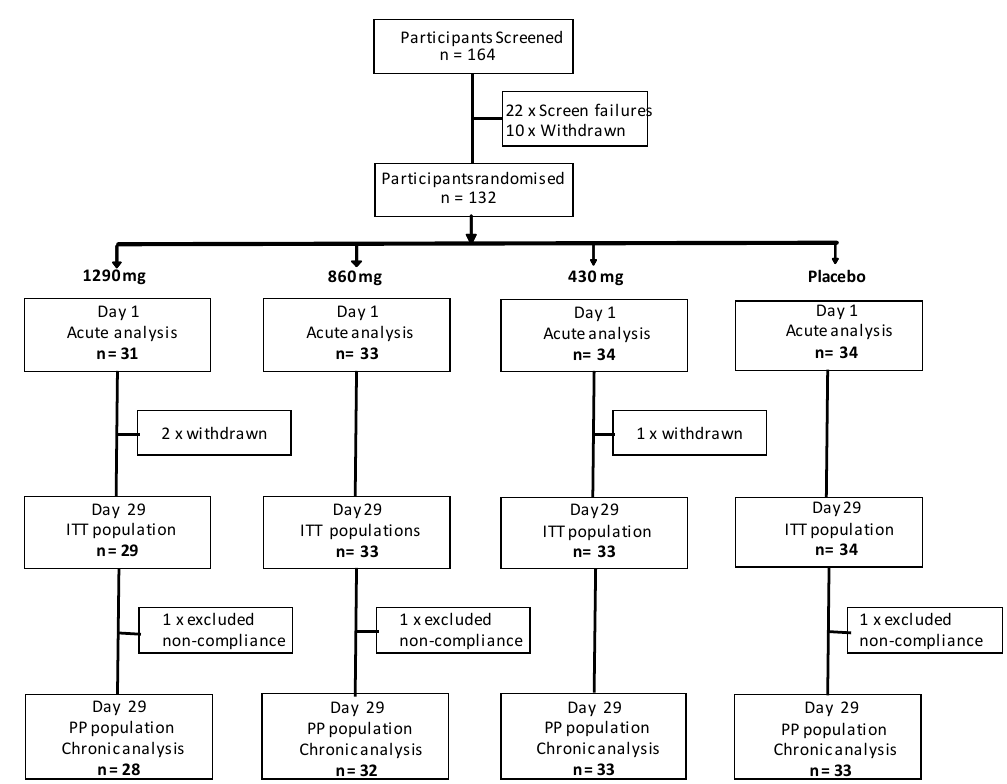
Figure 1. Participant dispositions throughout the trial.